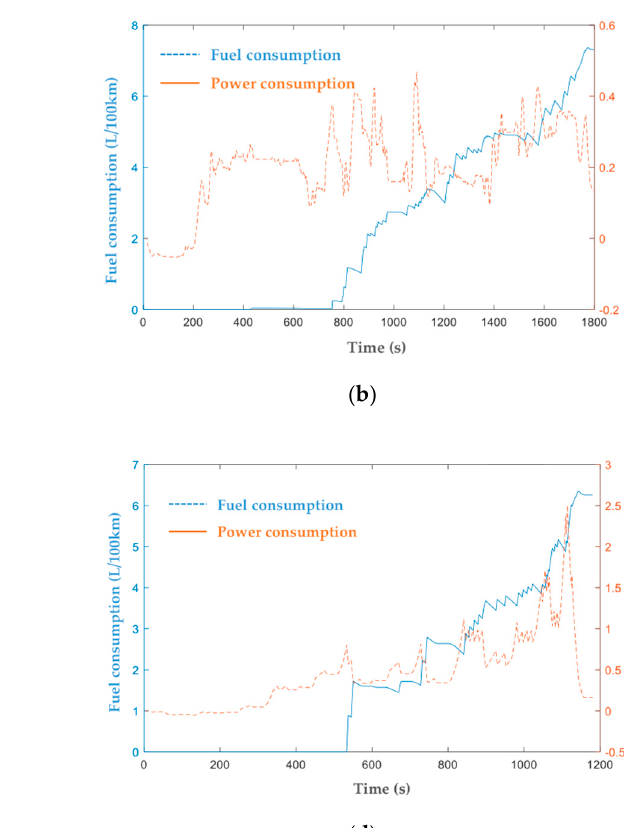
Figure 8. The flow diagram of the ECMS (Equivalent Consumption Minimization Strategy) algorithm.